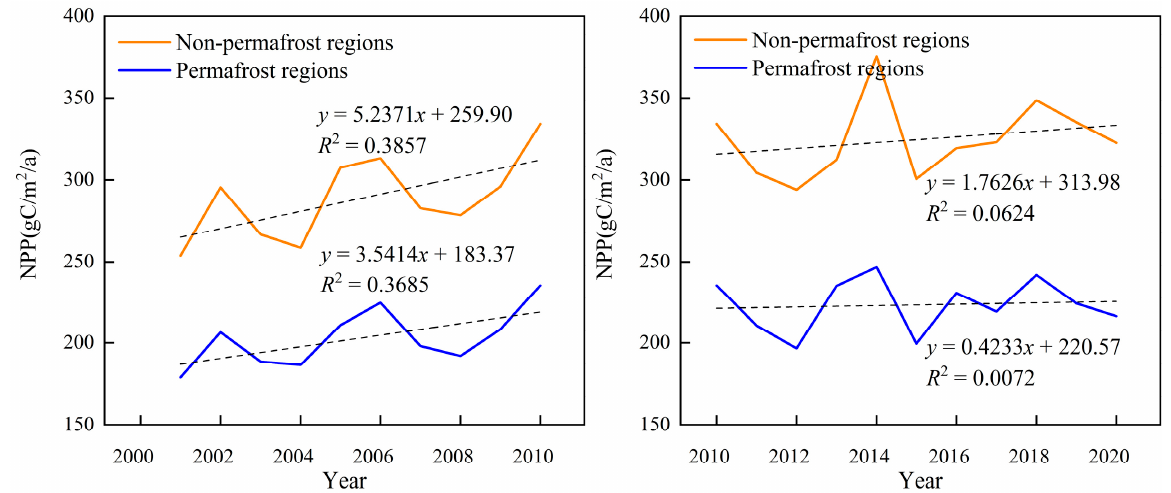
Figure 8. Trend of Net Primary Productivity (NPP) in permafrost and seasonal permafrost areas from 2001 to 2020.